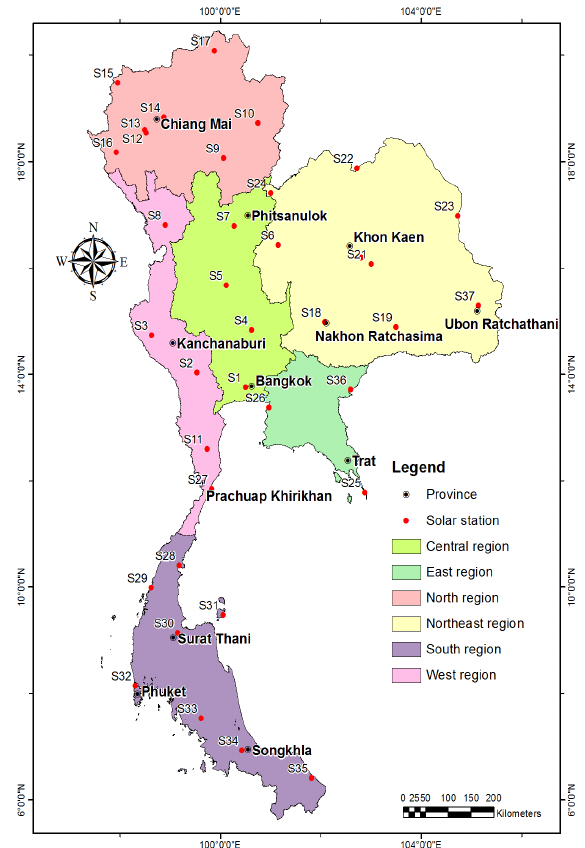
Figure 3. A map of solar radiation monitoring stations in